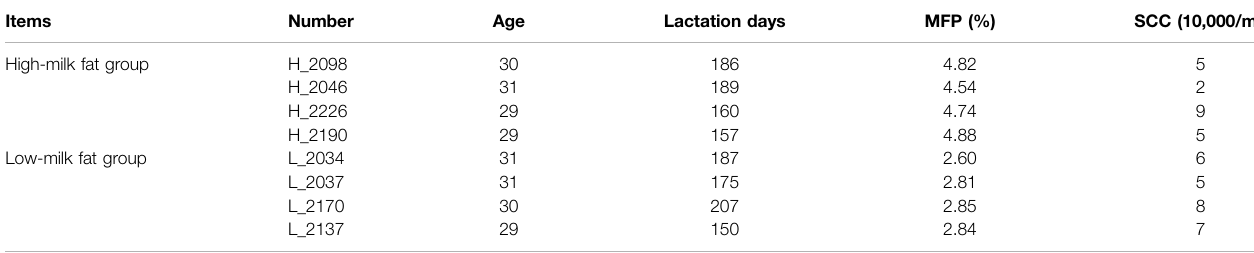
TABLE 2 | High and low MFP and SCC of Holstein cow.